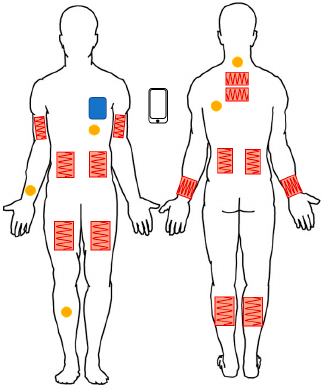
Figure 1. Placement of system components in the suit—left front, right back (red rectangles—heating insets; blue rectangle—embedded system; orange circles—temperature sensors).